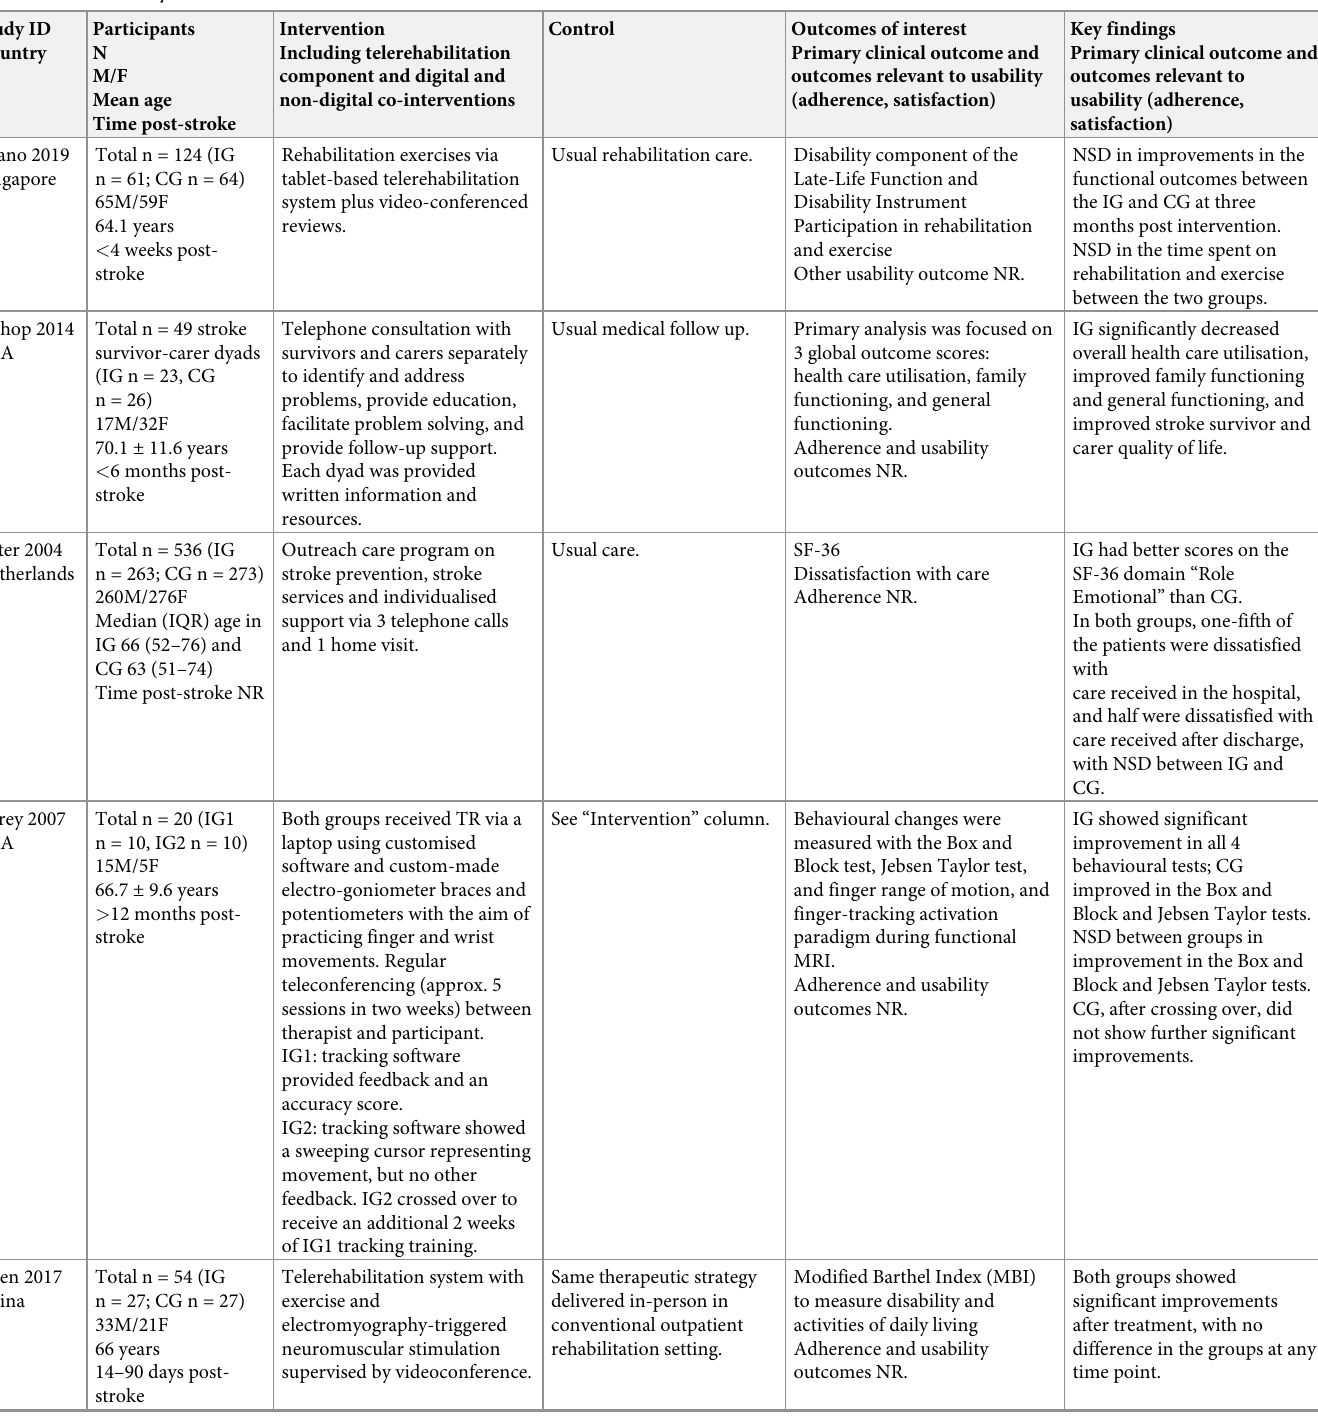
Table 1. Table of study